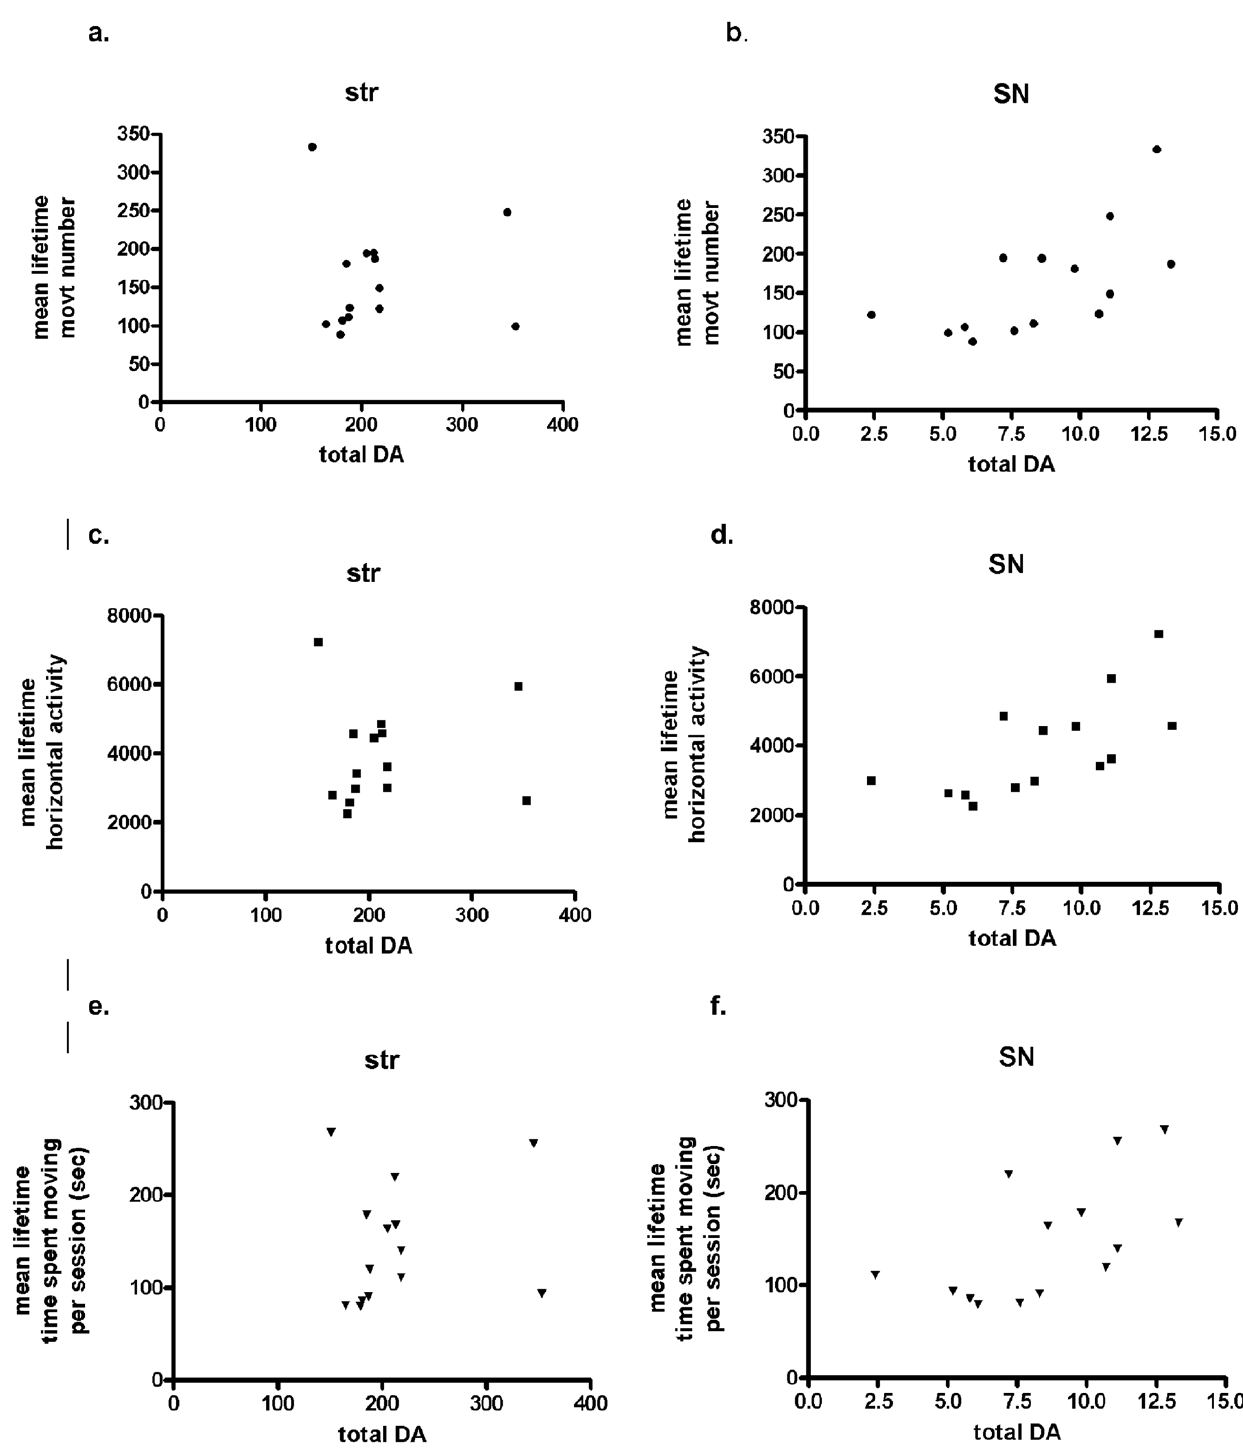
Figure 3. Dopamine bioavailability and correlation to locomotor activity generation. Total DA in striatum ((str) a, c, e) versus substantia nigra ((SN) b, d, f) and correlation to mean lifetime locomotor activity measures in all 14 subjects, ages 12 and 30 months ( n =7 each age group). The following are the Spearman correlation values and p -values; Movement number, a. str , p =0.65, r=0.13 b. SN , ** p =0.008, r=0.68, Horizontal activity, c. str , p =0.58, r=0.16 d. SN , ** p =0.008, r=0.72; Time spent moving, e. str , p =0.42, r=0.24 e. SN , * p =0.01, r=0.64. Additional statistical correlations are presented in Table 1.